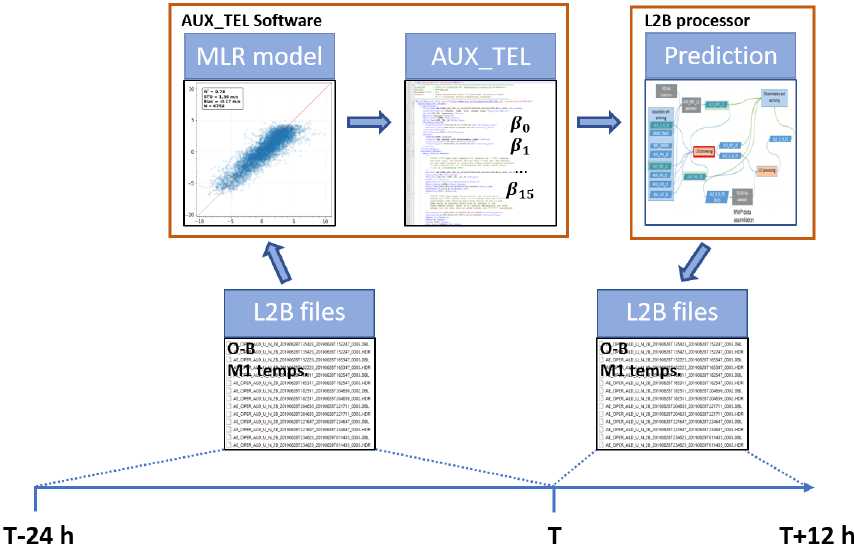
Figure 10. Flow chart of the operational M1 bias correction of the L2B wind results. In the AUX_TEL software, 24h of past L2B data with the E(O − B) -values as dependent and the 15 M1 temperatures as independent variables are used as input for the multiple linear regression (MLR) model. The model software produces an AUX_TEL file which contains the model coefficients β 0 ··· β 15 . Afterwards, the L2B processor uses the AUX_TEL files to make a prediction for the wind bias and to correct the wind results of the subsequent 12h window. Then, the AUX_TEL file is updated in the same